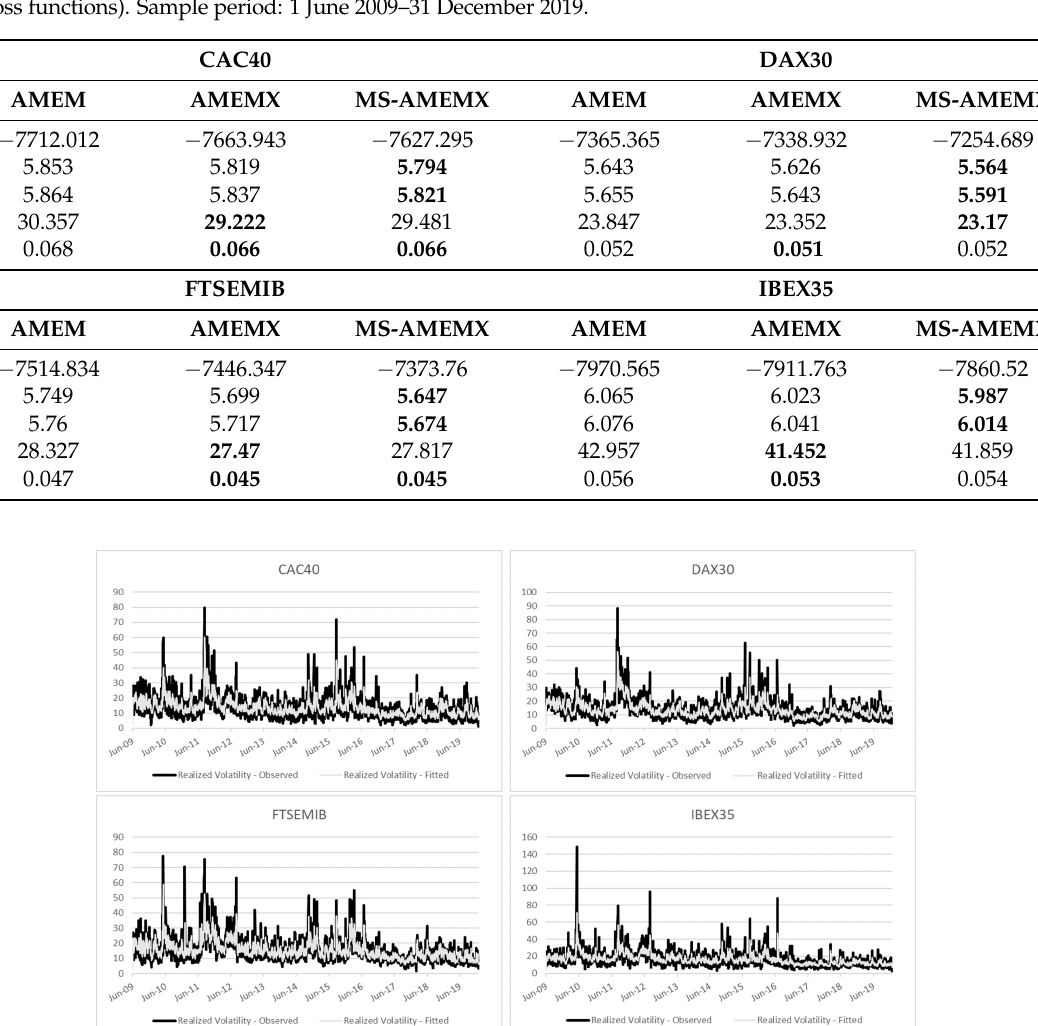
Table 6. Models comparison (best model in bold) through the Information Criteria (AIC and BIC) and forecasting capability (MSE and QLike loss functions). Sample period: 1 June 2009–31 December 2019.